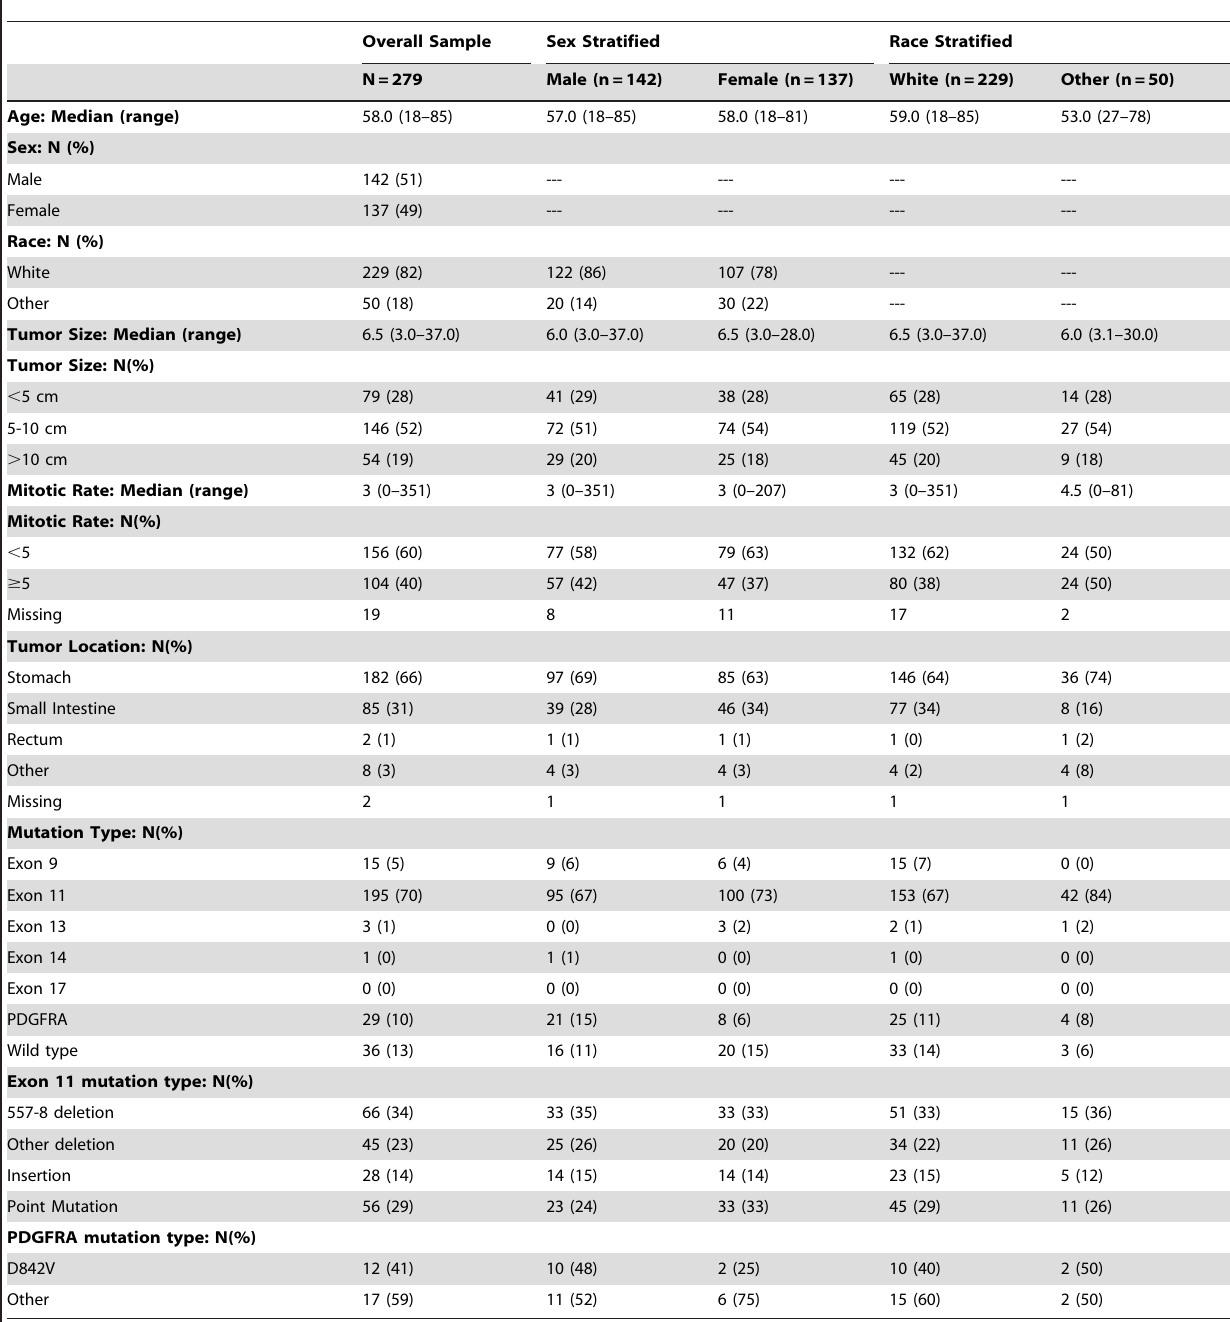
Table 1. Demographic information and tumor characteristics of patients included in genotyping ancillary